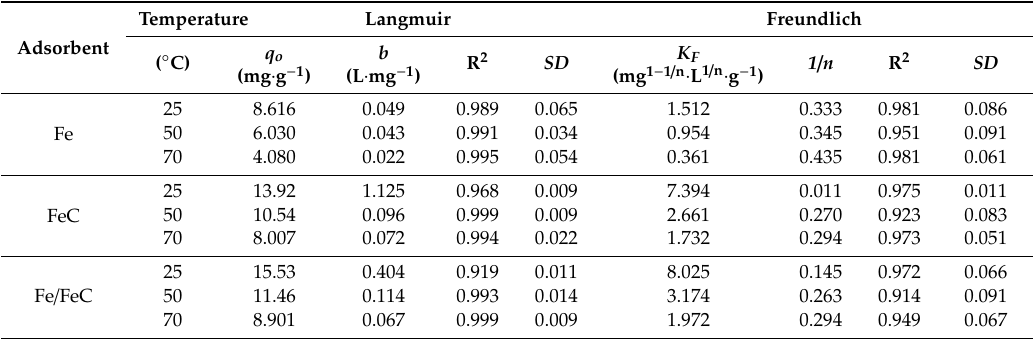
Table 4. Parameters of the Langmuir and Freundlich isotherm models for the adsorption the Acid Red 66 dye over the samples at distinct